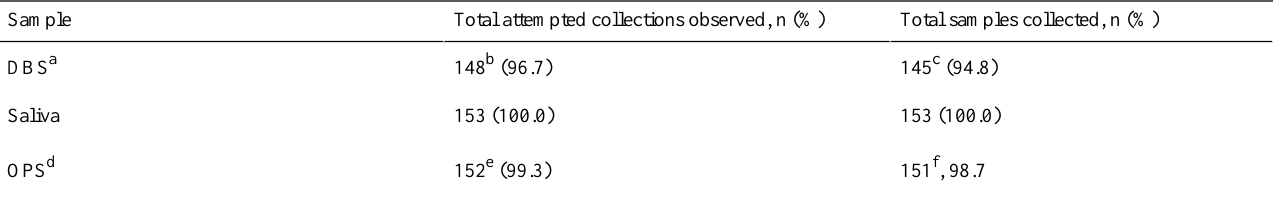
Table 2. Numbers of samples collected in the iCollect study with clinician assessment of the suitability of the collection procedures (n=153).